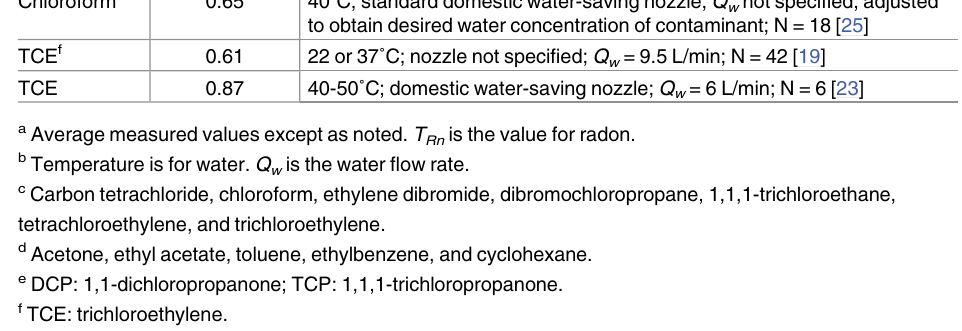
Temperature is for water. Q w is the water flow rate. c Carbon tetrachloride, chloroform, ethylene dibromide, dibromochloropropane,